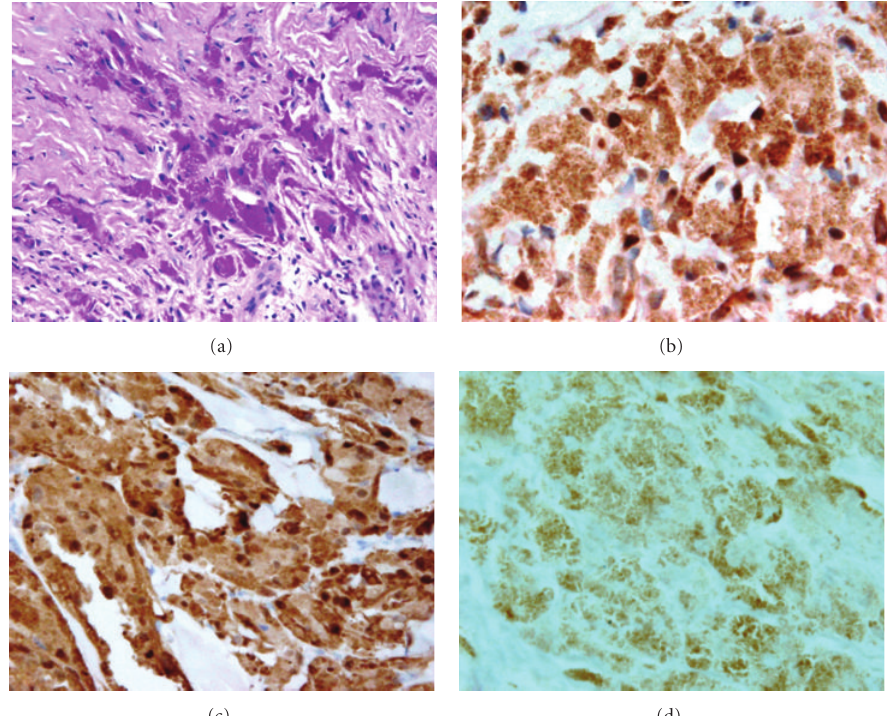
Figure 4: The tumor cells show PAS-positive cytoplasmic granules (a), strong positive immunostaining for S100 (b), and NSE (c) but weakly stained with CD68 (d) ( ×